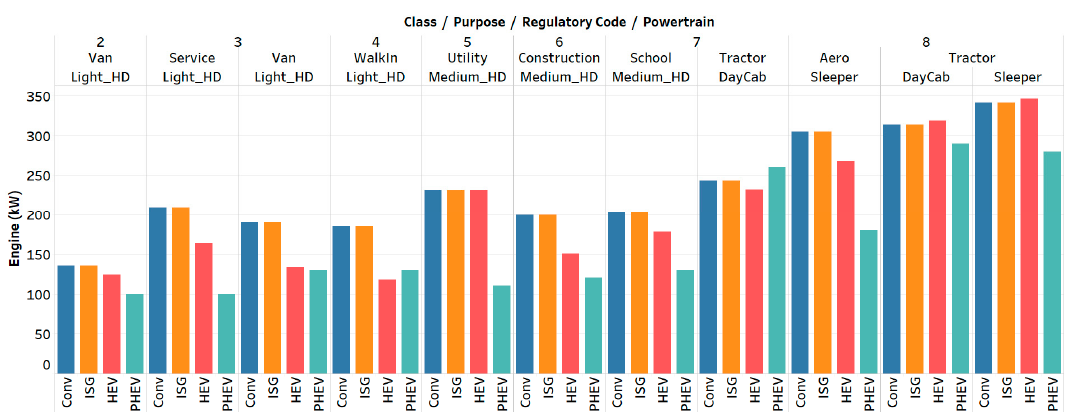
Figure 3. Engine size varies for each truck based on the powertrain choice.